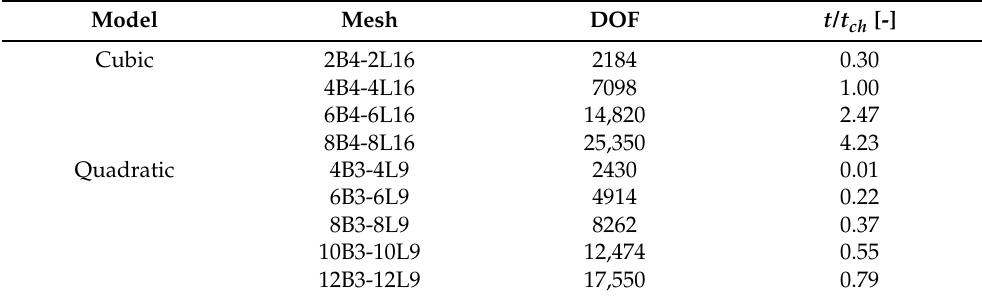
Table 5. Dimensionless CPU time for the different meshes employed with the present LW approach.